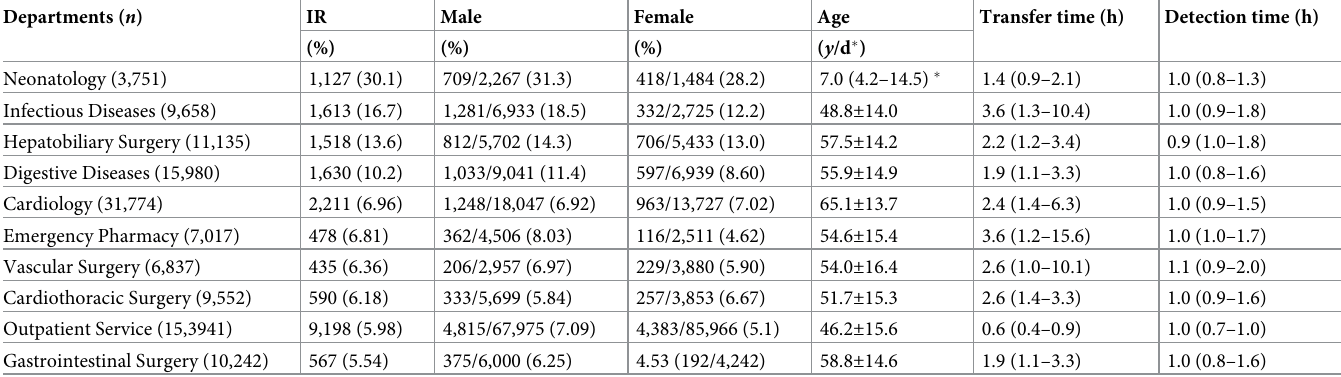
Table 6. The top 10 departments with the high incidence rate of icterus (n = 259,887).